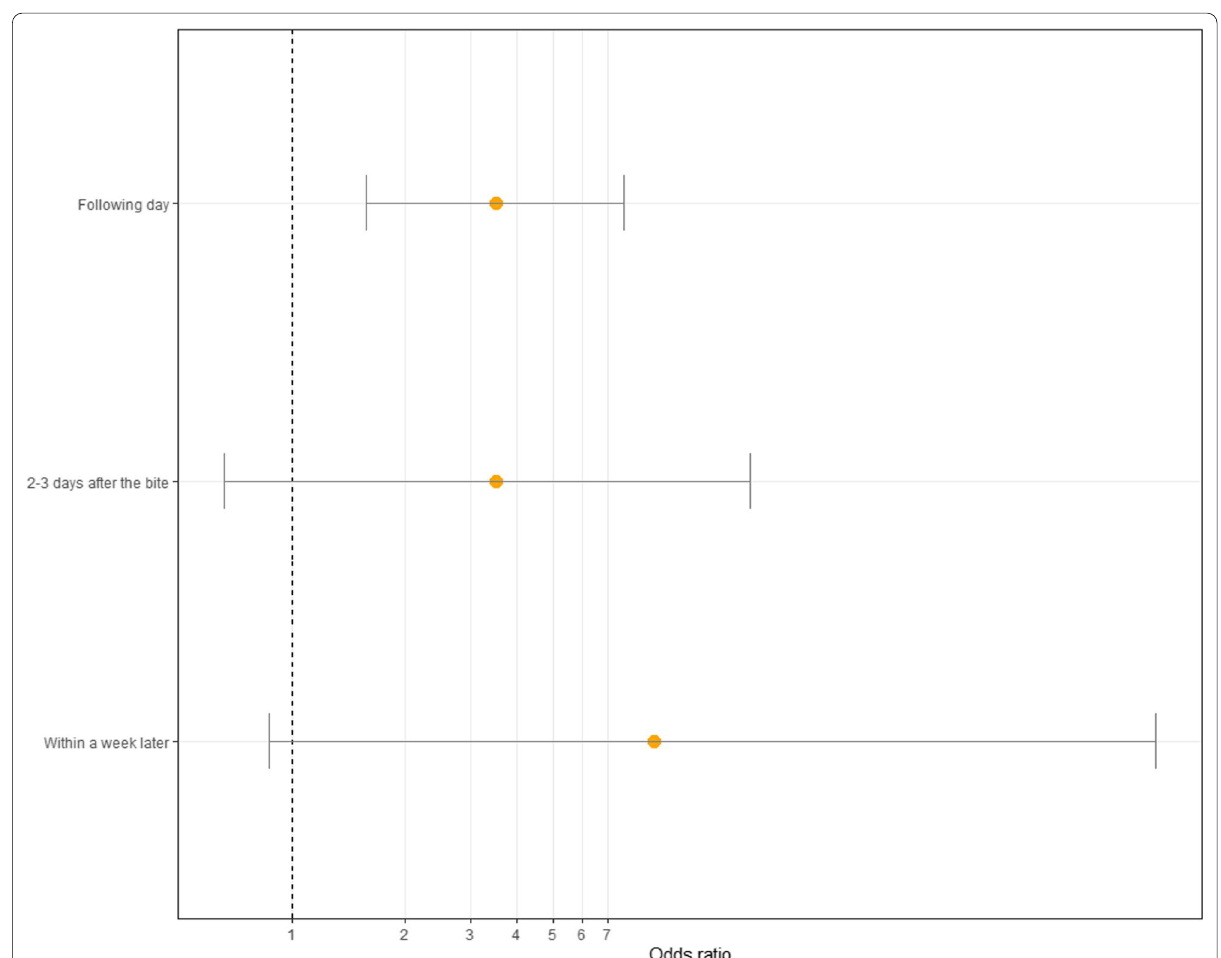
Fig. 4 Odds ratios and confidence intervals from a logistic regression models of severe outcomes (defined as death, paralysis, permanent disability or loss of consciousness) and time to treatment. Reference is same day